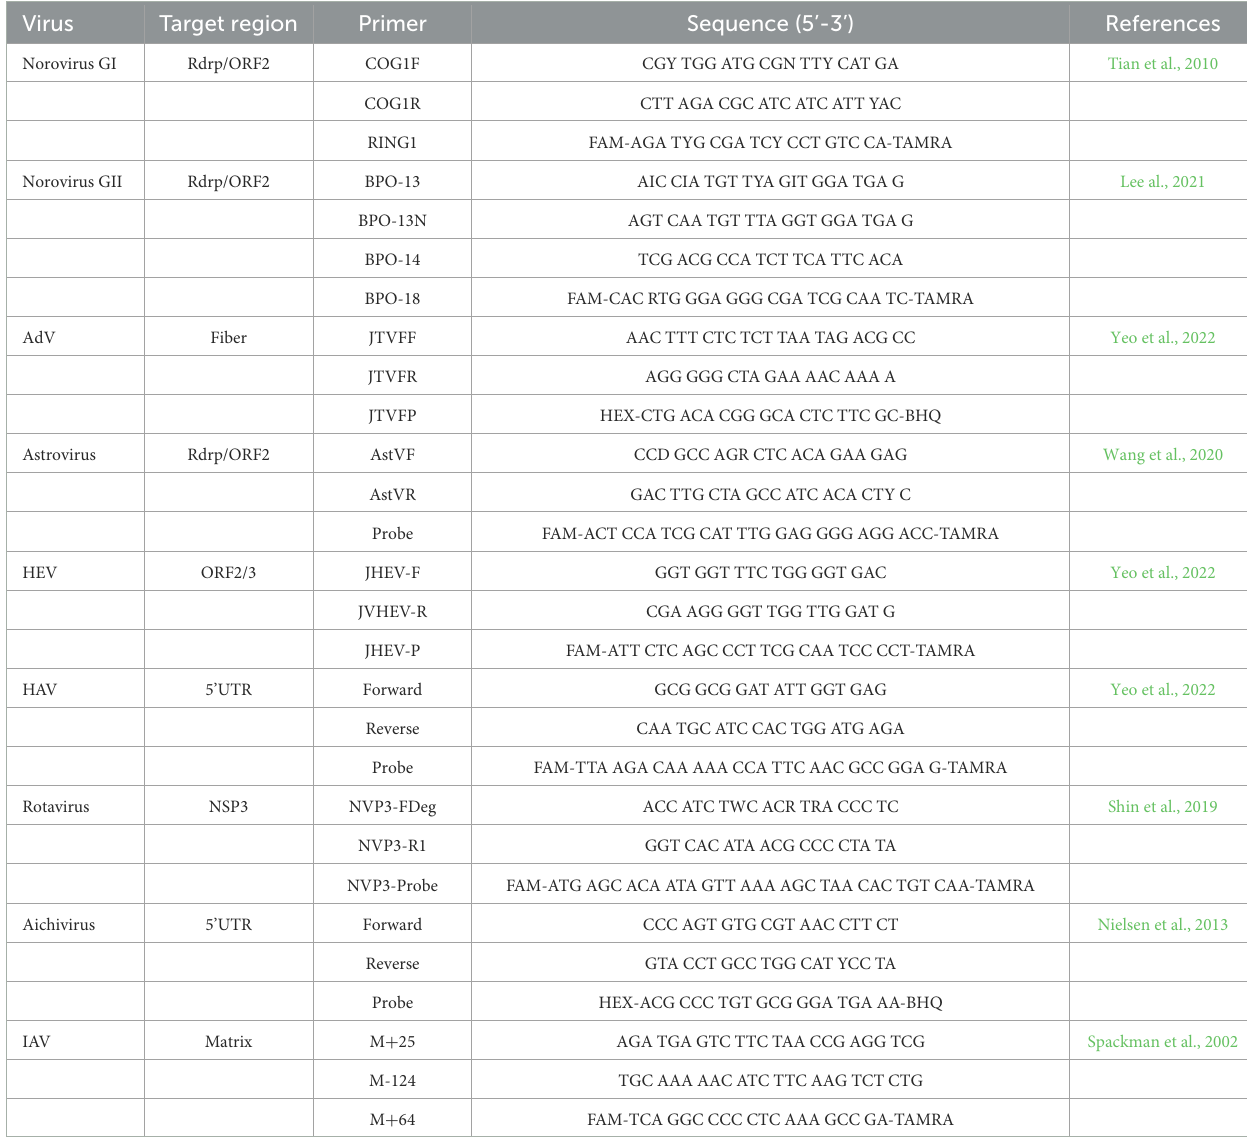
TABLE 2 Primers and probes for foodborne viruses and influenza A virus monitoring in RT-qPCR and